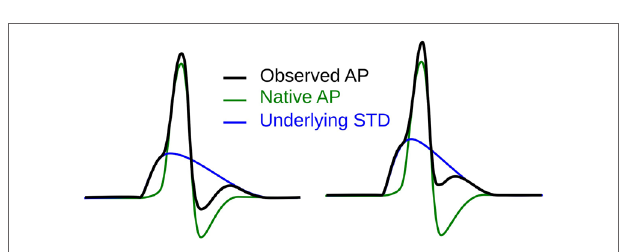
FIgURe 3 | Hypothesis for the generation of sAPs involving the variable superposition of an underlying STD and a native AP profile.